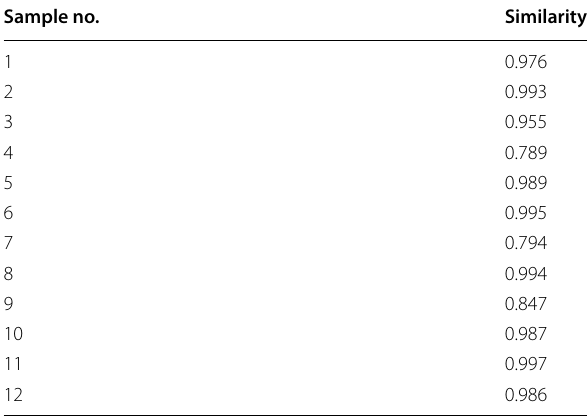
Table 3 Similarities of the 12 batches of Resina Draconis Sample